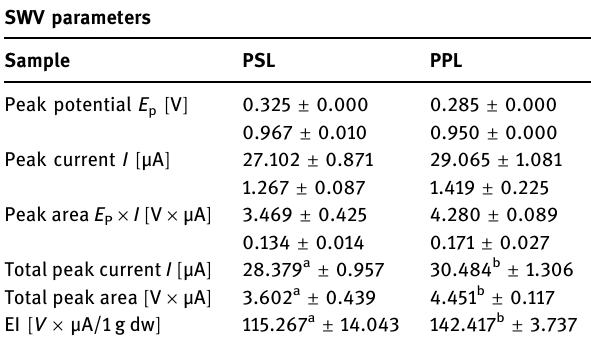
Table 4: P. padus and P. serotina leaf extracts with FRAP, DPPH, ABTS radicals and total polyphenol content